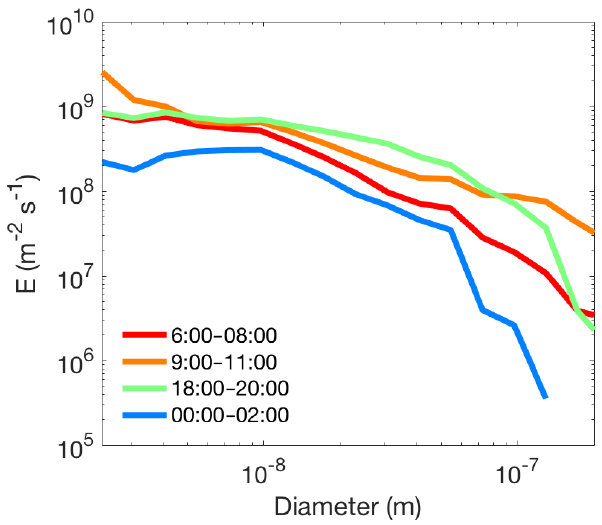
Figure A3. Average particle number emission size distributions on non-NPF event days at different times.